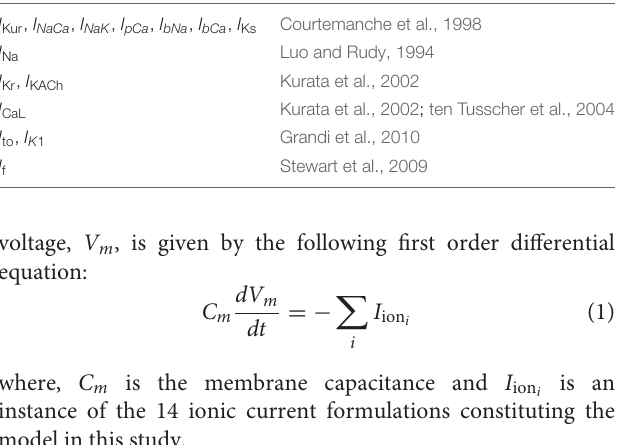
Frontiers in Physiology |